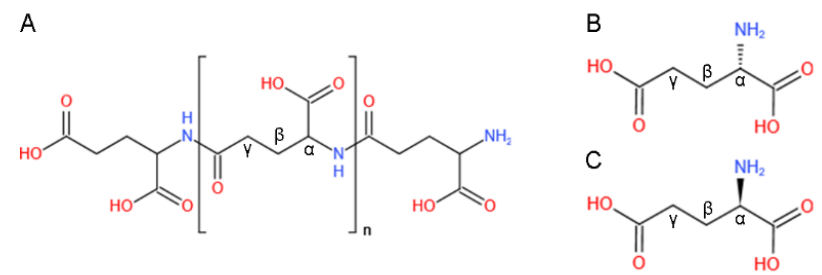
Figure 1. The structural formula of γ-PGA and its constituent units. The polymer of γ-PGA (n: repeating units approach at least 10,000) ( A ) and the L-glutamic acid monomer ( B ) and D-glutamic acid monomer ( C ) of γ-PGA.